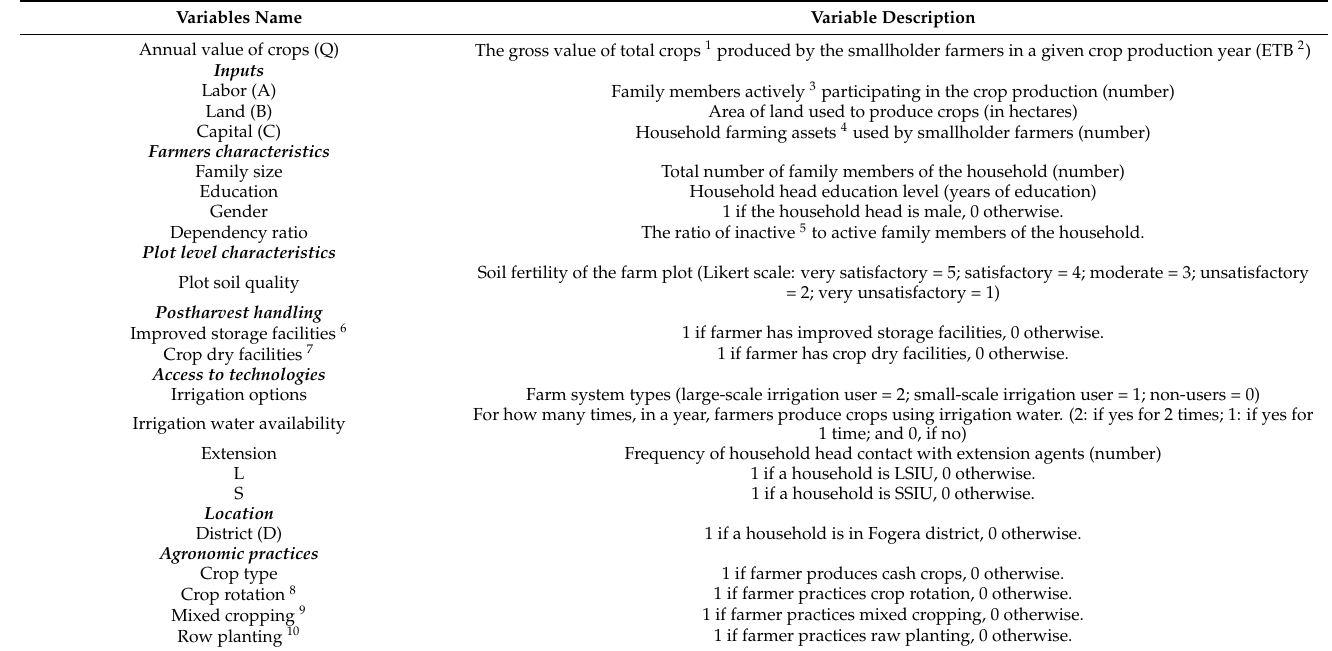
Table 1. Description of the variables used in the SFA